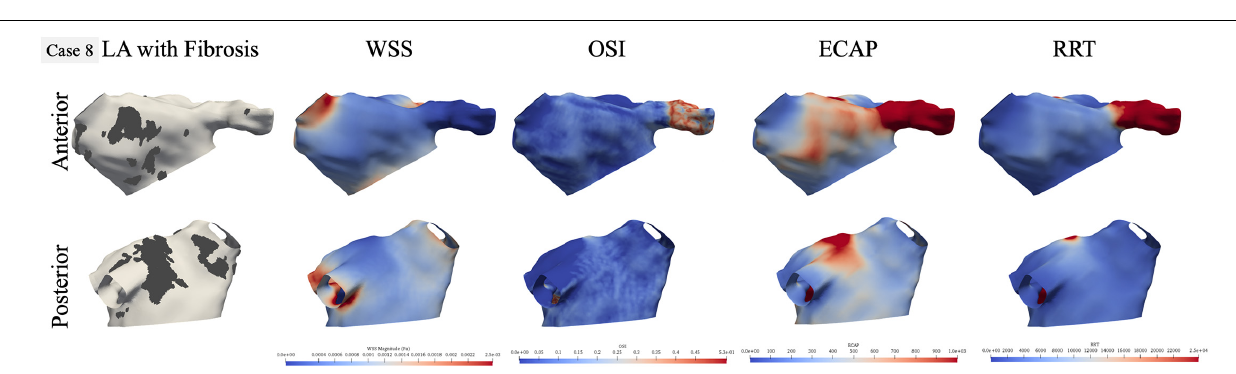
FIGURE 5 | Qualitative comparison of personalized left atrial (LA) hemodynamic results with LA fibrotic burden for the representative paroxysmal atrial fibrillation (AF) case 8. Dark gray region in the left panel represents the fibrosis at the LA wall. Other panels show WSS, OSI, ECAP, and RRT contours, respectively: blue color represents low value, and red color represents high